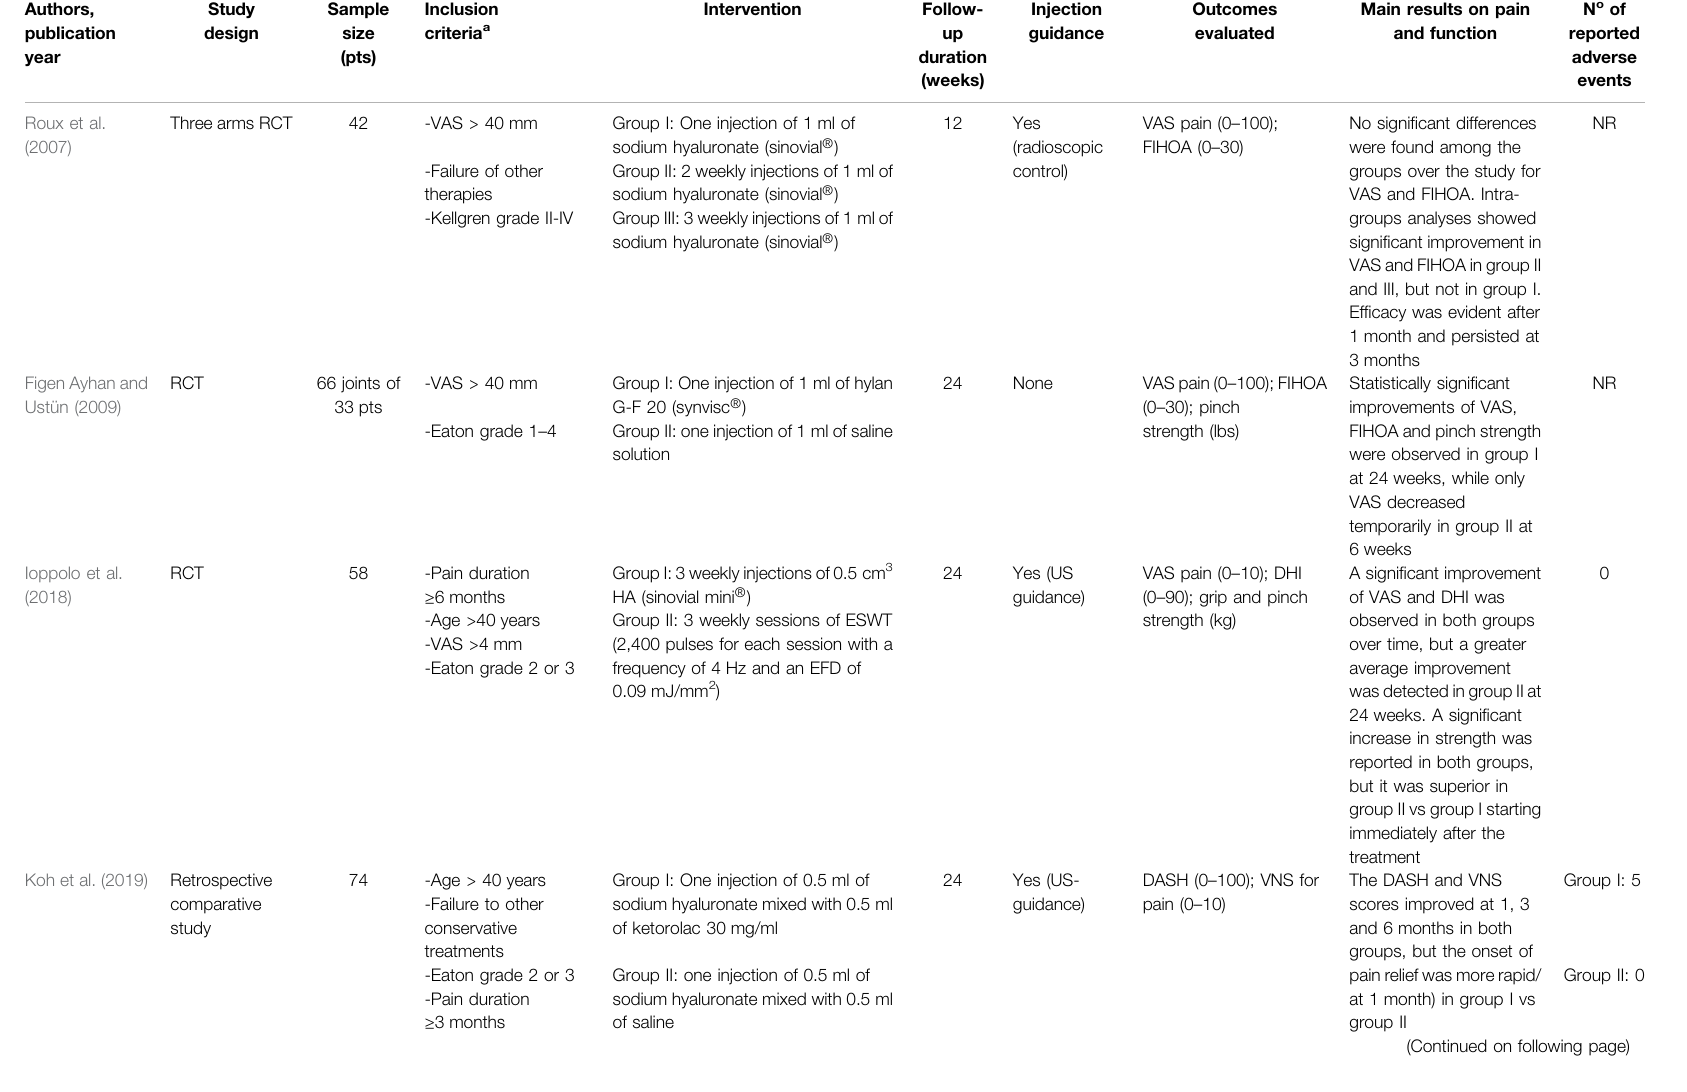
TABLE 2 | ( Continued ) Summary of studies investigating intra-articular injections of hyaluronic acid for the treatment of thumb-base